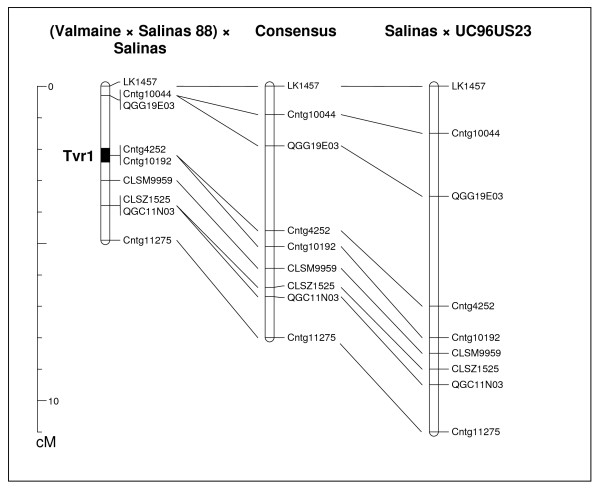
Part of chromosomal linkage group 2, showing nine markers linked to the Tvr1 gene. The map on the left is based on segregation observed in the (Valmaine × Salinas 88) × Salinas population, the map on the right is based on segregation observed in the Salinas × UC96US23 population, and the map in the center is a consensus map developed from the two linkage maps. A black bar on the (Valmaine × Salinas 88) × Salinas map indicates the estimated position of the Tvr1 gene.